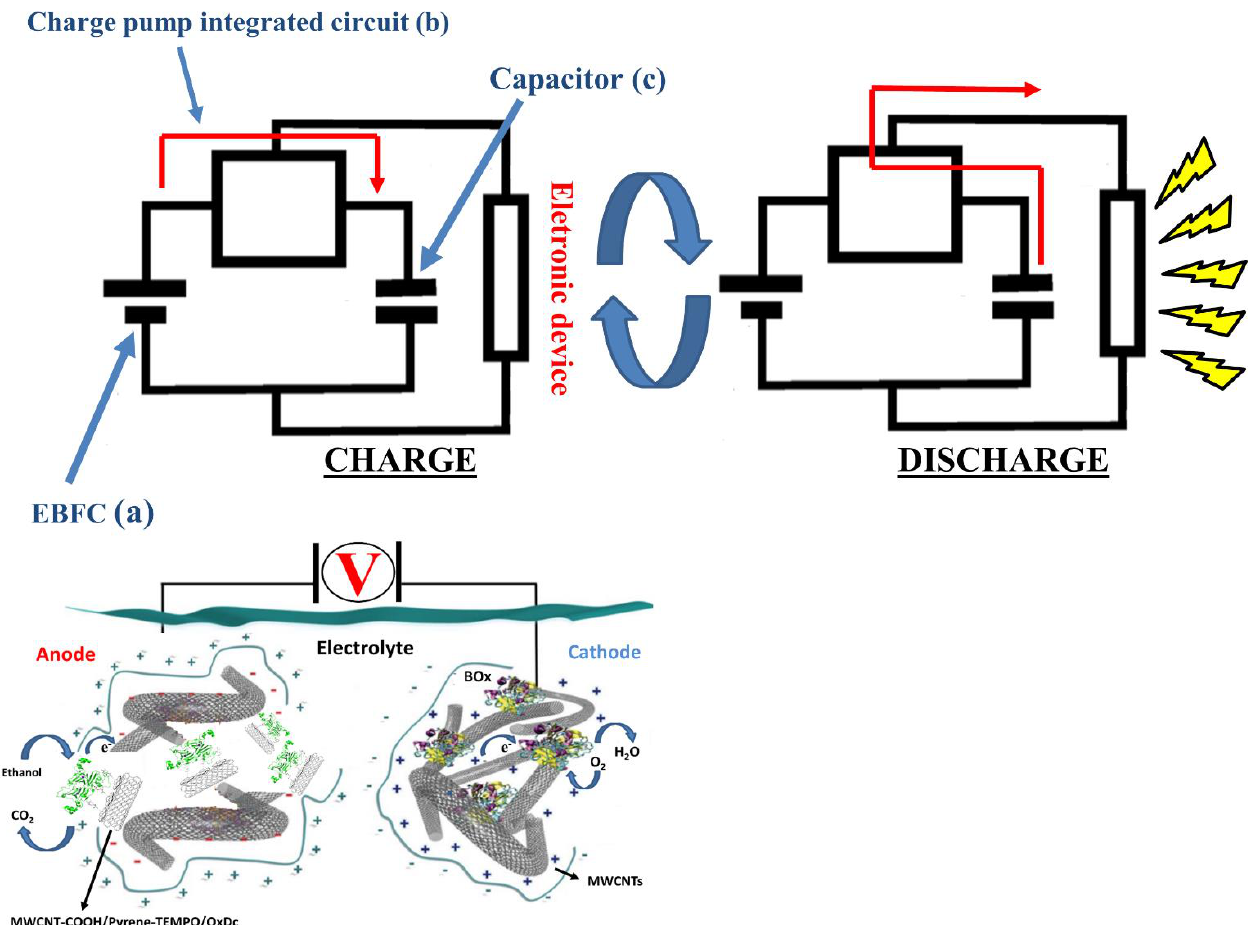
Figure 7. Representative model of the principle of a supercapacitor (SC)-EBFC: a charge pump-integrated circuit ( b ) is employed to scale up the voltage of the EBFC ( a ), and a capacitor ( c ) is used to store the electrical energy. When the capacitor voltage reaches the set value, the stored electrical energy can be discharged from the capacitor to activate a device, such as an LED bulb. At the anode is OxDC (oxalate decarboxylase enzyme), and at the cathode is BOx (bilirubin oxidase).